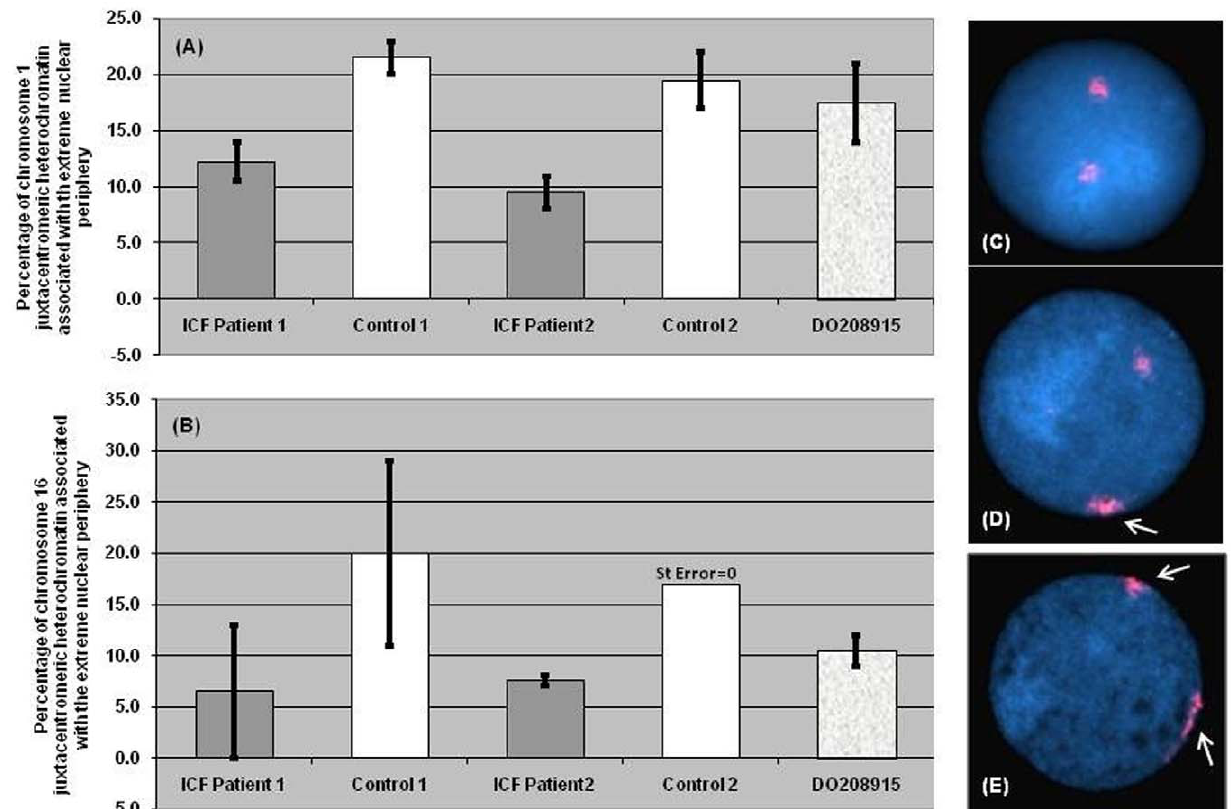
Figure 6. Association of chromosome 1 and 16 juxtacentromeric heterochromatin with the extreme nuclear periphery. Preferential positioning of the chromosome 1 (A) and chromosome 16 (B) juxtacentromeric heterochromatin at the nuclear periphery was assessed in ICF Patient 1 and 2, Control 1 and 2, and DO208915. The heterochromatic signals were considered to be positioned at the extreme nuclear periphery if any part of them appeared to associate with the nuclear rim, as defined by the edge of the DAPI staining. Panels C, D and E respectively show examples of nuclei where none or either one or both chromosome 1 heterochromatic areas (D1Z1 signal in red) map at the extreme nuclear periphery (as indicated by the white arrows). The reduction in association of the D1Z1 and D16Z3 hybridisation signals with the extreme nuclear periphery in ICF B- cell lines compared to controls is in both cases statistically significant using a Chi-squared goodness of fit test, respectively ( x 2 =4.882, P=0.027) and ( x 2 =10.563, P=0.001).